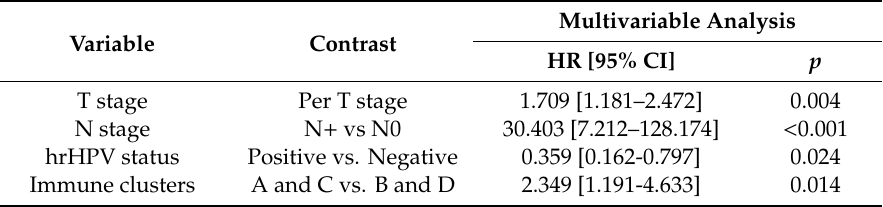
Table 2. Multivariate Cox regression analysis of immune clusters associated with